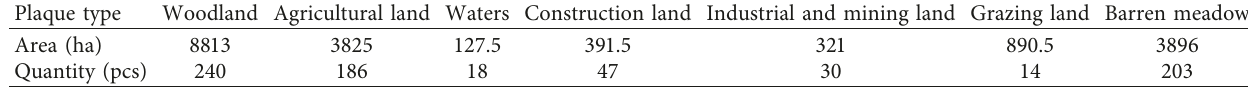
Table 4: Basic data of plaque types in the Yanchong section of 4–1 Jingli expressway.